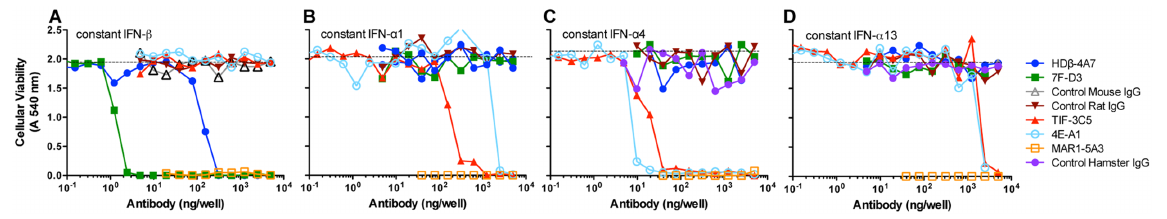
Fig 4. In vitro neutralizing activity of Type I IFN mAbs. Approximately 20 units of recominant IFN- β ( A ) or IFN- α 1 ( B ), IFN- α 4 ( C ) or IFN- α 13 ( D ) were preincubated for 1 h with indicated mAbs and then added to L929 cells overnight. Constant levels of Type I IFN used in these assays are as follows: IFN- β , 4.4 ng; IFN- α 1, 0.15 ng; IFN- α 4, 0.05 ng; IFN- α 13, 34 ng. IFN-treated cells subsequently were infected with VSV for 48 h and cell viability determined by crystal violet staining and optical density measurements. Results shown are representative of two independent experiments.